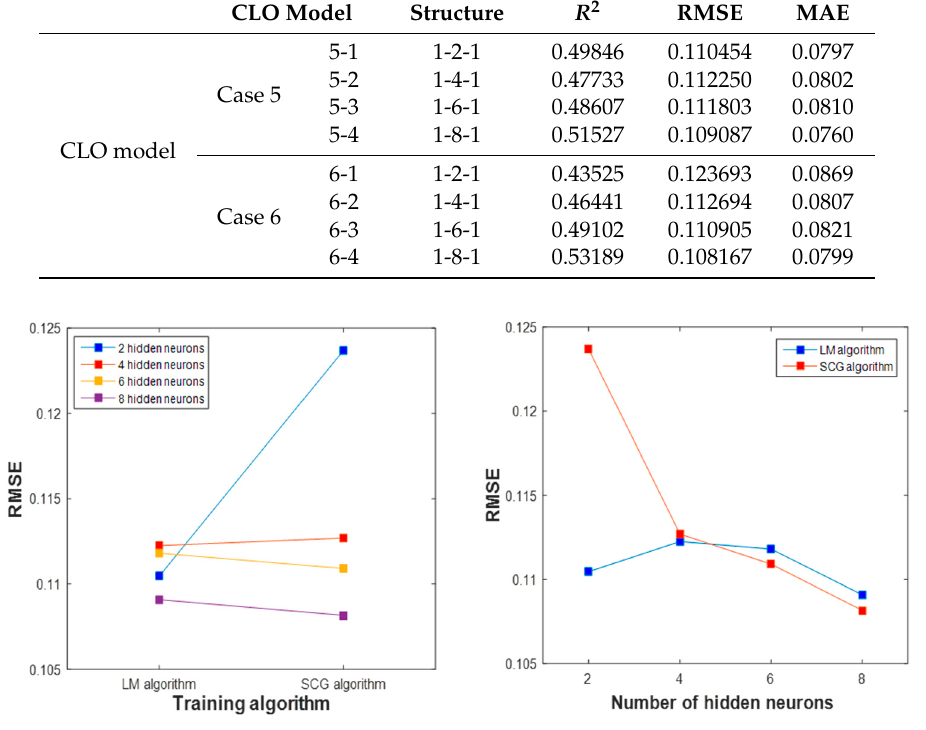
Figure 8. Results of RMSE for CLO prediction models according to the floors and number of datasets. Table 7. Accuracy of CLO prediction models according to the model structures.